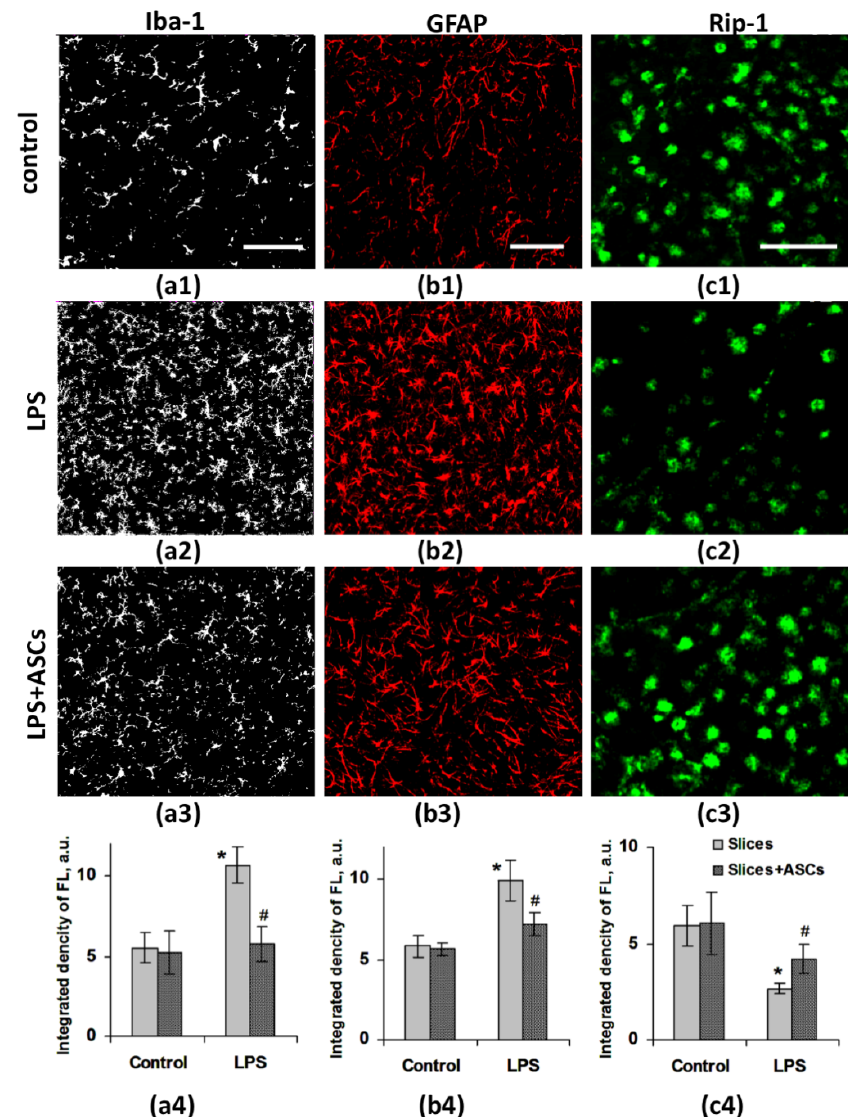
Figure 4. The confocal images of brain slices in control ( a1 , b1 , c1 ), 48 h after LPS ( a2 , b2 , c2 ) and LPS + ASCs co-culture ( a3 , b3 , c3 ). ( a1 – a4 ) microglia (marker Iba-1—white); ( b1 – b4 ) astrocytes (marker GFAP—red); ( c1 – c4 ) oligodendrocytes (marker Rip-1—green) in brain slice culture of mouse. ASCs—adipose-derived stem cells, LPS—lipopolysaccharide. Scale bar—500 μ m. ( a4 , b4 , c4 ) histograms of integrated fluorescence density (n = 8). a.u.—arbitrary units. Note: *—statistically significant di ff erence compared with control ( p < 0.05), #—statistically significant di ff erence compared with LPS ( p < 0.05). n = the number of analyzed slices in the